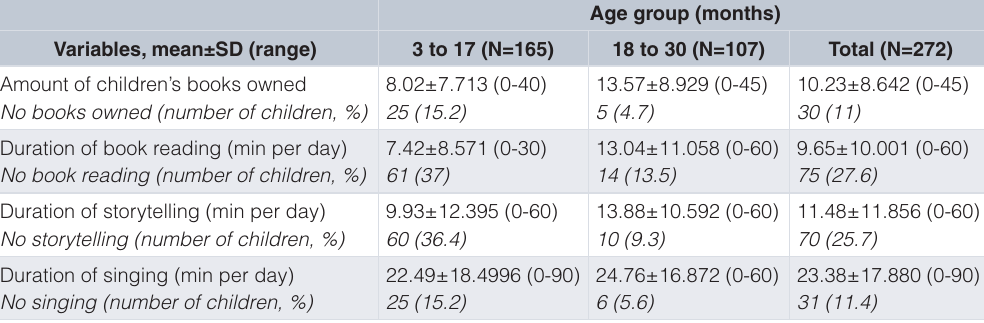
Table 2. Early Storybook Reading situation of infants and